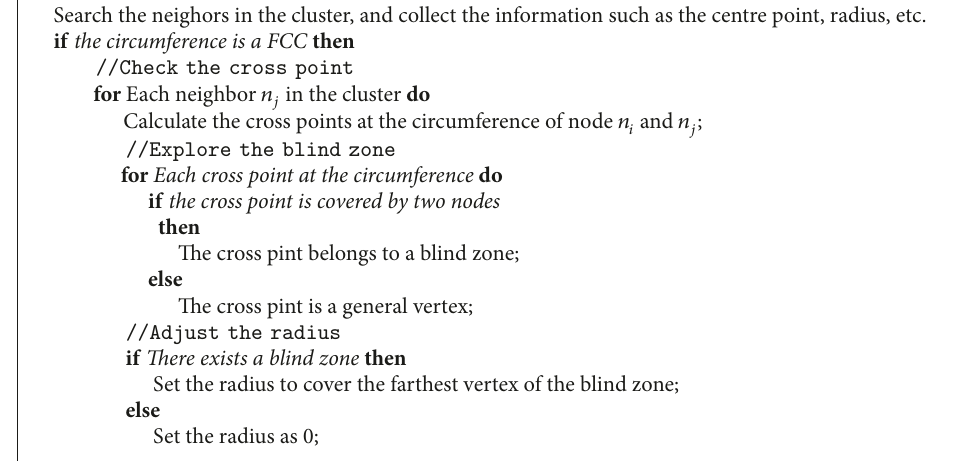
Algorithm 1: The adaptive subdividing at node 𝑛 𝑖 .